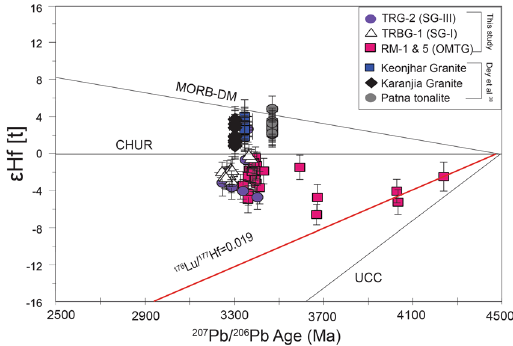
Figure 4. ɛ Hf[t] vs. 207 Pb/ 206 Pb age (Ma) plot of zircons from samples RM-1, RM-5, TRBG-1 and TRG-2. Data from contemporary Singhbhum TTGs ( ∼ 3.5-3.3 Ga) are from Dey et al . 39 . Note all data from present study are subchondritic and Hadean and Eoarchean xenocrysts follow 176 Lu/ 177 Hf = − 0.019 array. The isotope trajectory of UCC (Upper continental Crust; 176 Lu/ 177 Hf = 0.008) is after Rudnick and Gao 66